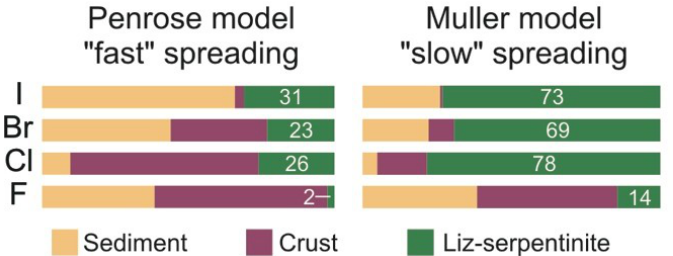
Figure 5. Summary of F, Cl, Br and I budget calculations for an incoming slab according to Penrose-type and Muller-type models of oceanic lithosphere produced at fast- and slow-spreading centers, respectively. The Penrose model consists of 400 m sediment, 6000 m igneous crust and 500 m lizardite serpentinites. The Muller model consists of 400 m sediment, 3500 m igneous crust and 300 m lizardite serpentinites. Average halogen concentrations for each unit are reported in Table 1. Numbers in bars denote the percent contribution of serpentinite to the total budget for each element.